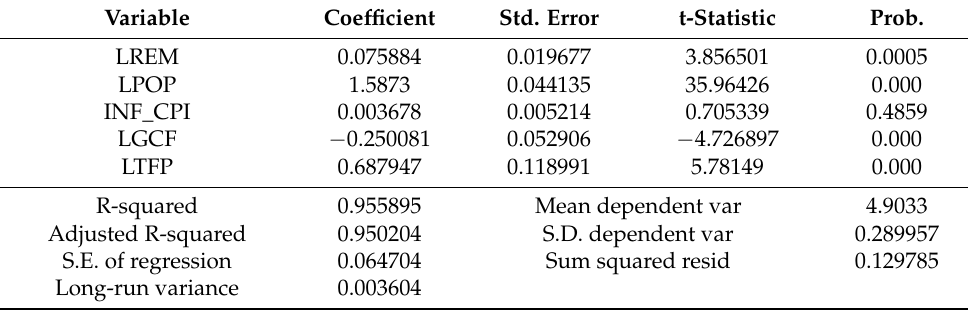
Table 5. Method: Fully Modified Least Squares (FMOLS).